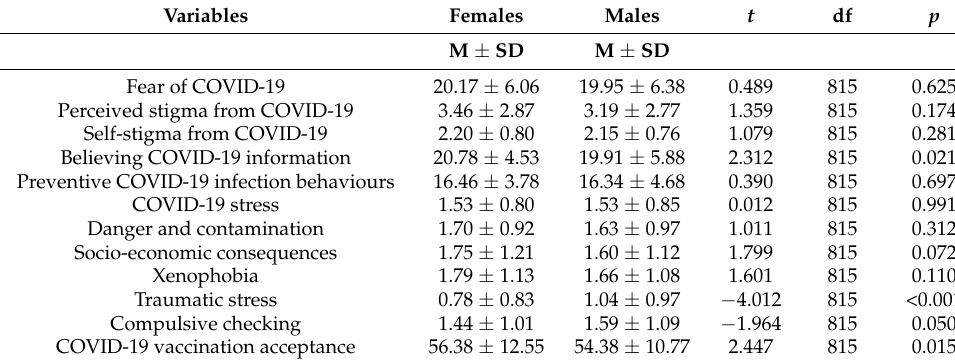
Table 2. Sex differences on the COVID-19-related